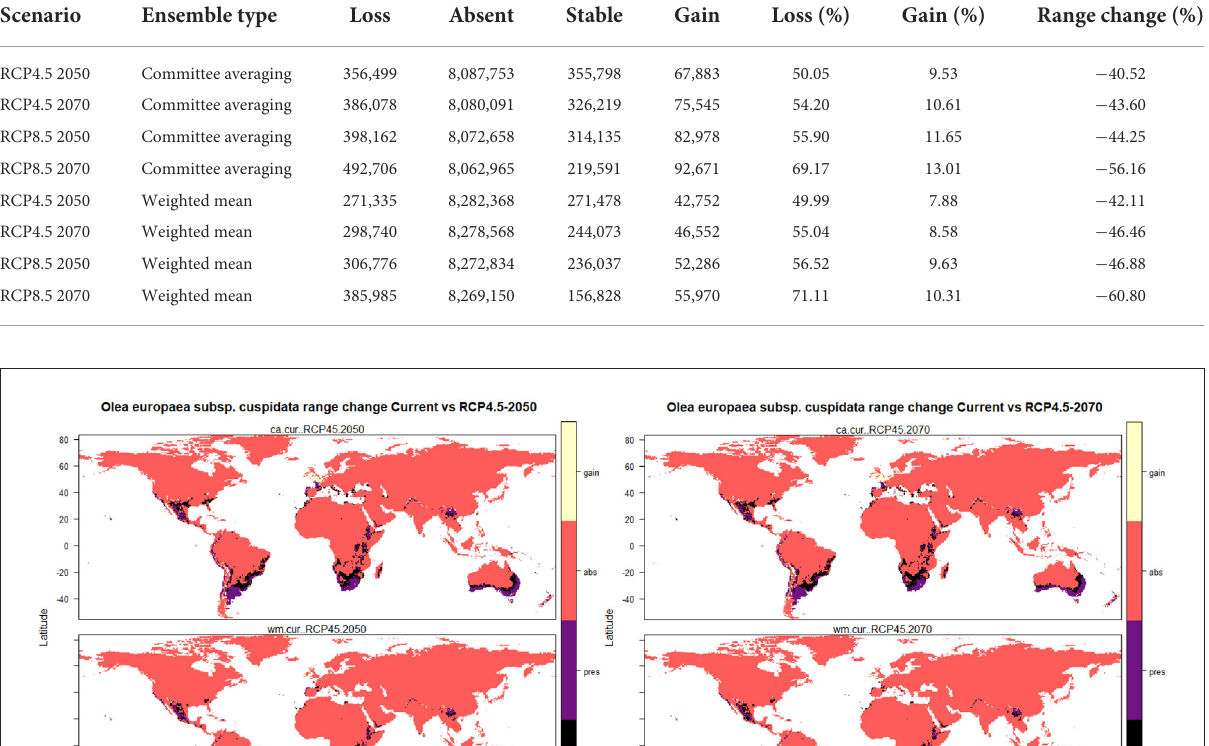
TABLE 3 Summary of the range change statistics in terms of pixels for the Olea europaea subsp. c uspidata under climate change scenarios compared to current climatic conditions.